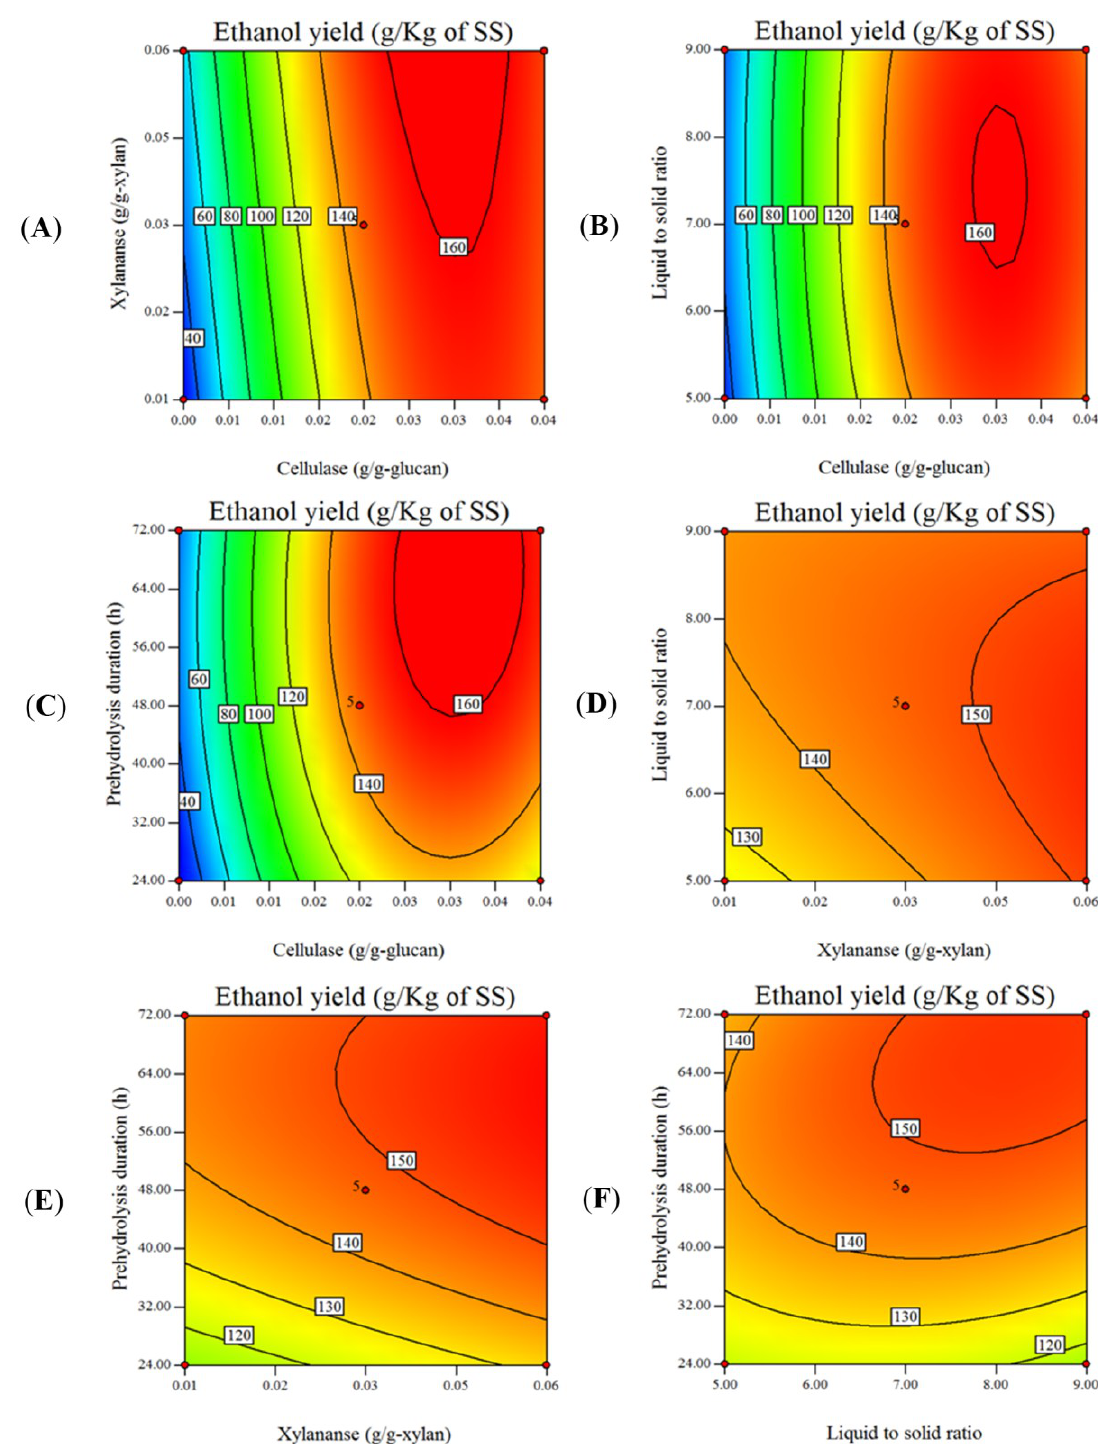
Figure 2. Contour plots for the effects of two variables on the ethanol yield while the other two variables were held constant at the